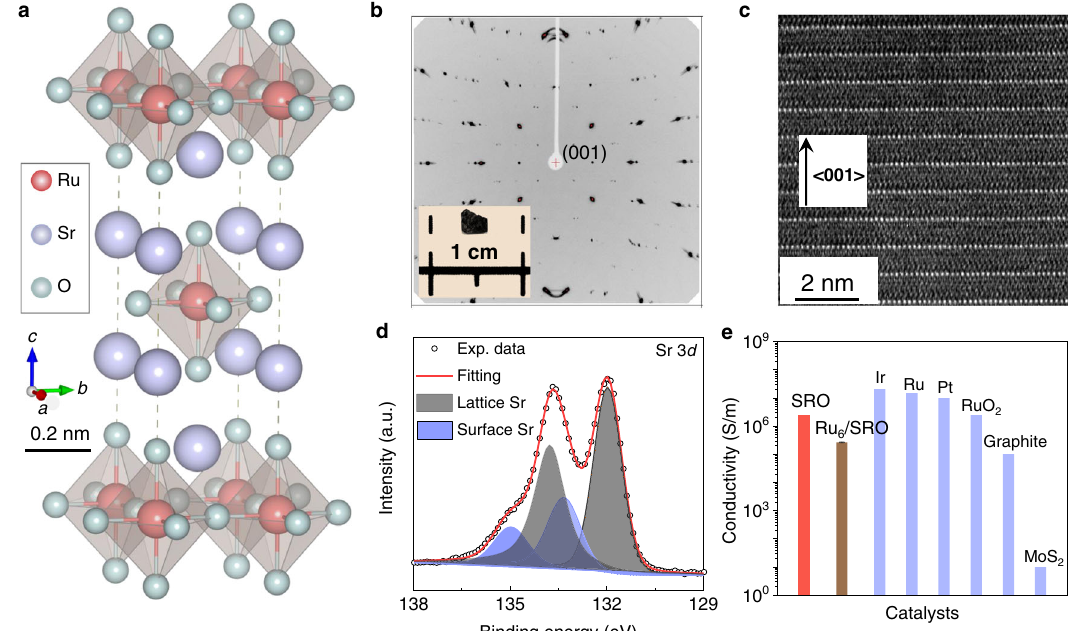
Fig. 1 | Crystal structure of fresh Sr 2 RuO 4 single crystals. a Three-dimensional crystal structure of layered SRO crystal. The light purple, pink, and gray balls represent Sr, Ru, and O atoms, respectively. b Laue diffraction pattern of the SRO crystal recording along the [100] direction. A photograph of the exfoliated SRO single crystal by exposing the (001) surface. c TEM image of the fresh SRO crystal recordedonaFIBlaminar.ThebrightatomsrepresentthealternativelyarrangedSr